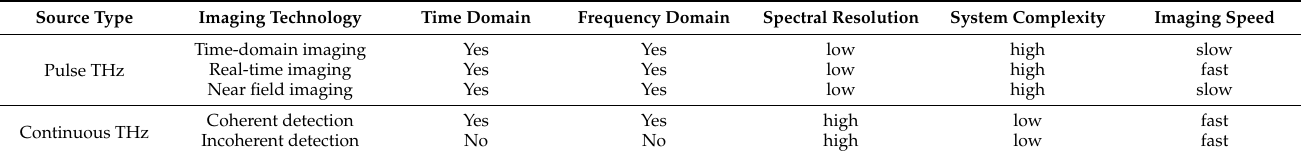
Figure 1. THz spectral imaging system and applications. Table 1. Common THz spectral imaging techniques and their characteristics.